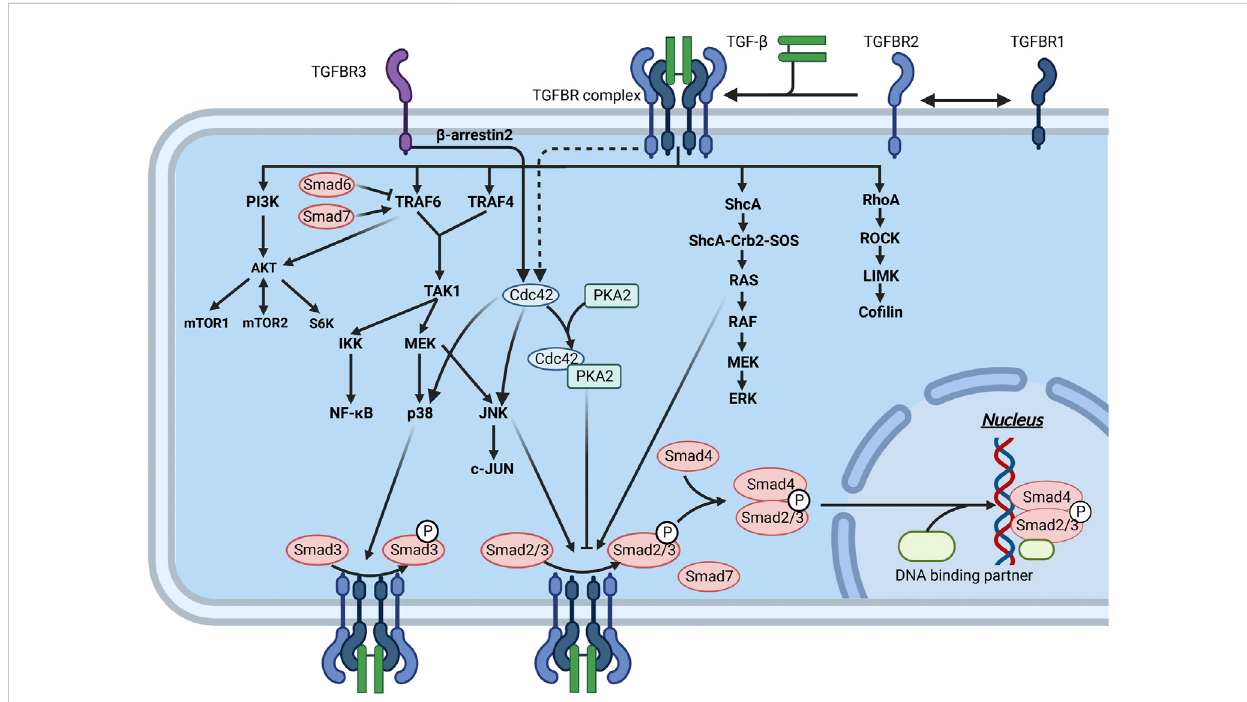
FIGURE 6 Interaction of the TGF- β signaling pathway through Smad and non-Smad pathways in fi brosis. Mature TGF- β binds to TGFBR and acts on downstream molecules through theSmad and non-Smadpathways, thereby regulating ECM production. The downstream molecules of these pathways can interact with the molecules of the Smad pathway to inhibit or promote ECM